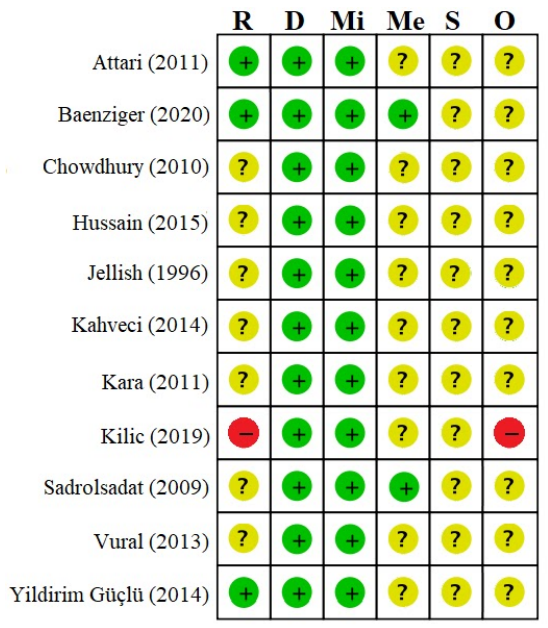
Figure 2. Summary of bias evaluated by the Risk of Bias 2 Tool. R: Bias arising from the randomi- zation process, D: Bias due to deviations from intended interventions, Mi: Bias due to missing outcome data, Me: Bias in measurement of the outcome, S: Bias in the selection of the reported result, and O: Overall risk of bias. Green “+”: Low risk of bias, Yellow “?”: Some concerns, Red “-”: High risk of bias.